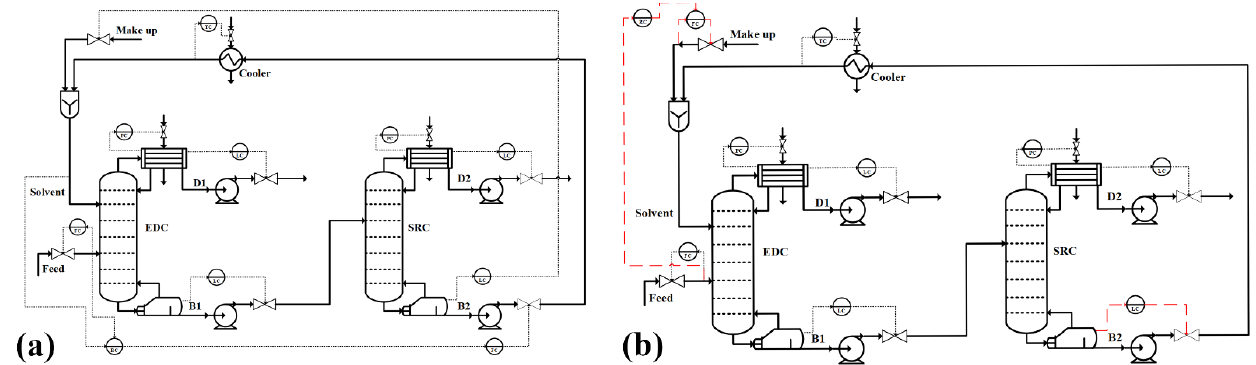
Figure 4. ( a ) Basic inventory control commonly employed in the literature and ( b ) alternative inventory control with the make-up flowrate ratio to the feed flowrate.